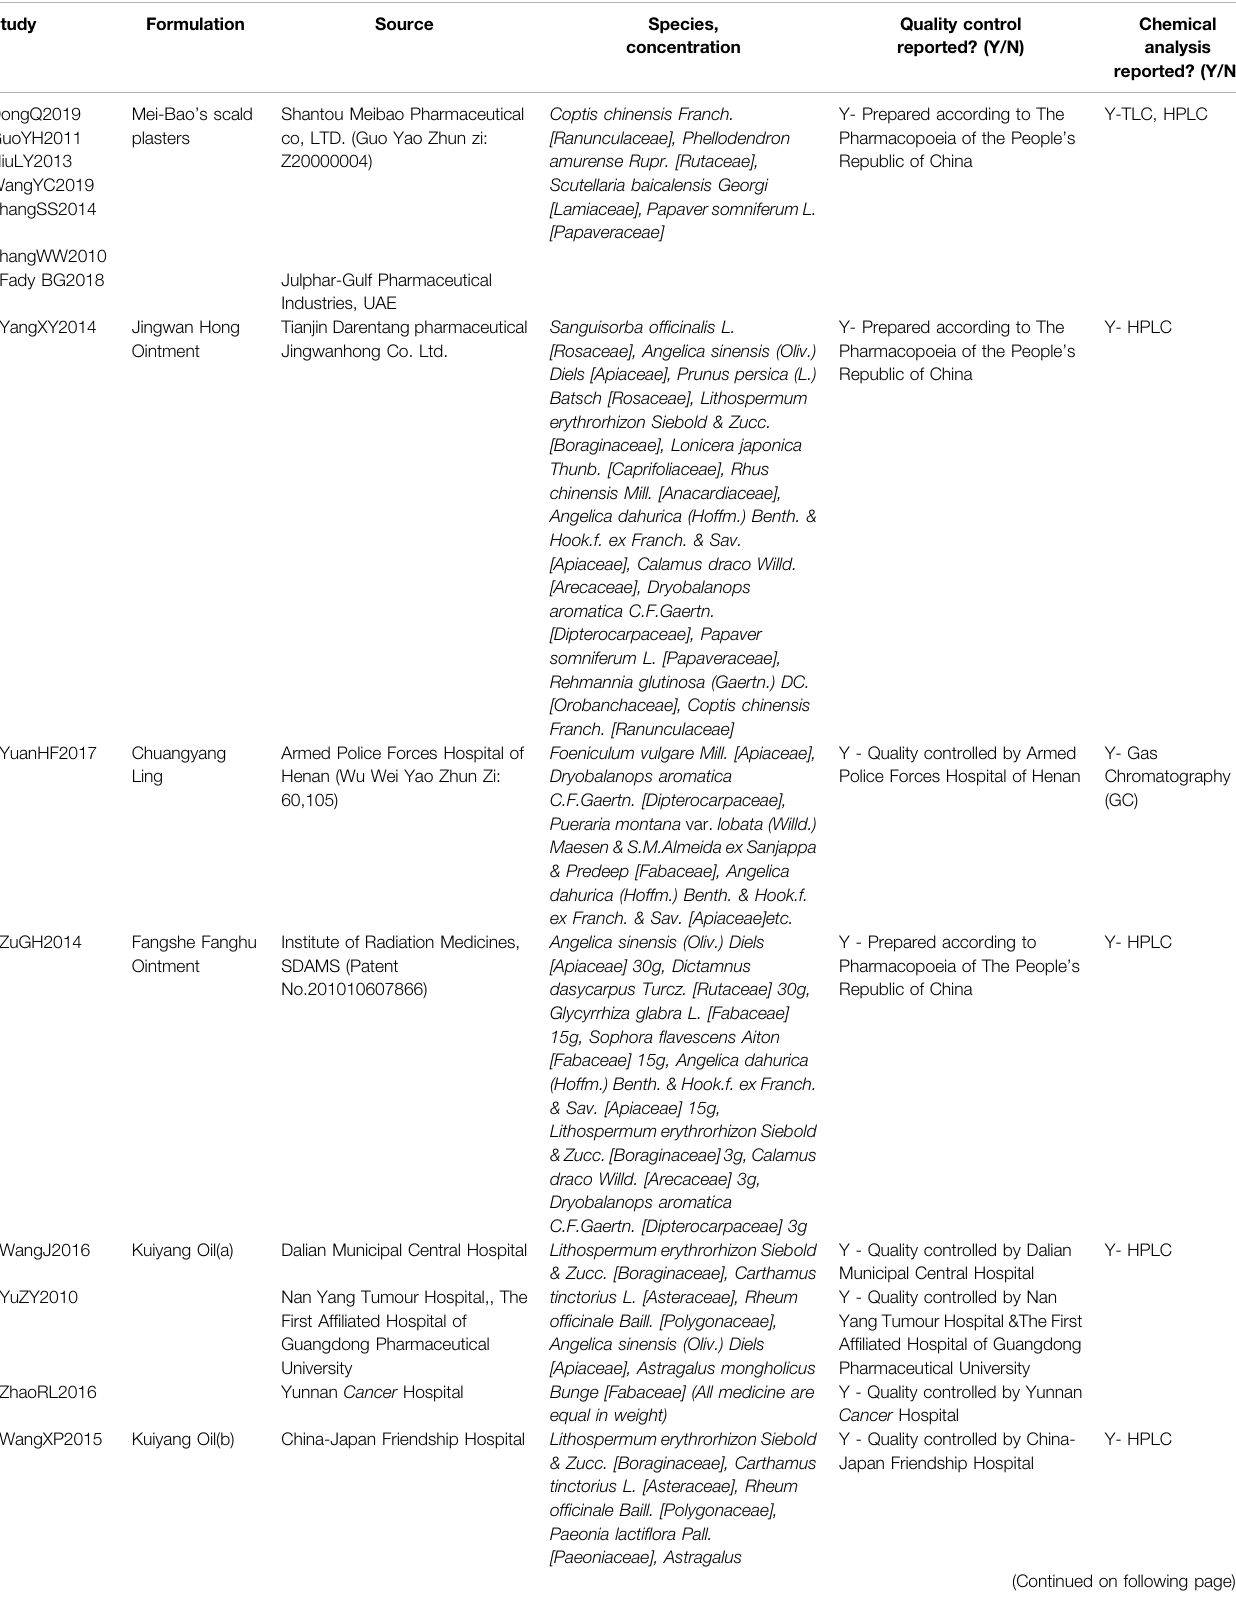
TABLE 5 | Patented formulations, botanical or chemical, of the articles